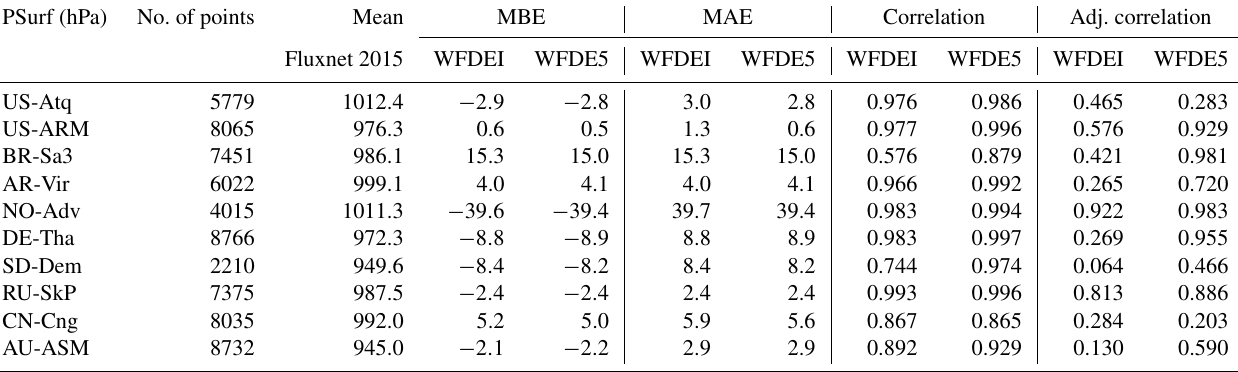
Table A10. PSurf metrics for each FLUXNET2015 site: WFDEI versus FN2015 and WFDE5 versus FN2015 at 3-hourly time steps. PSurf (hPa)